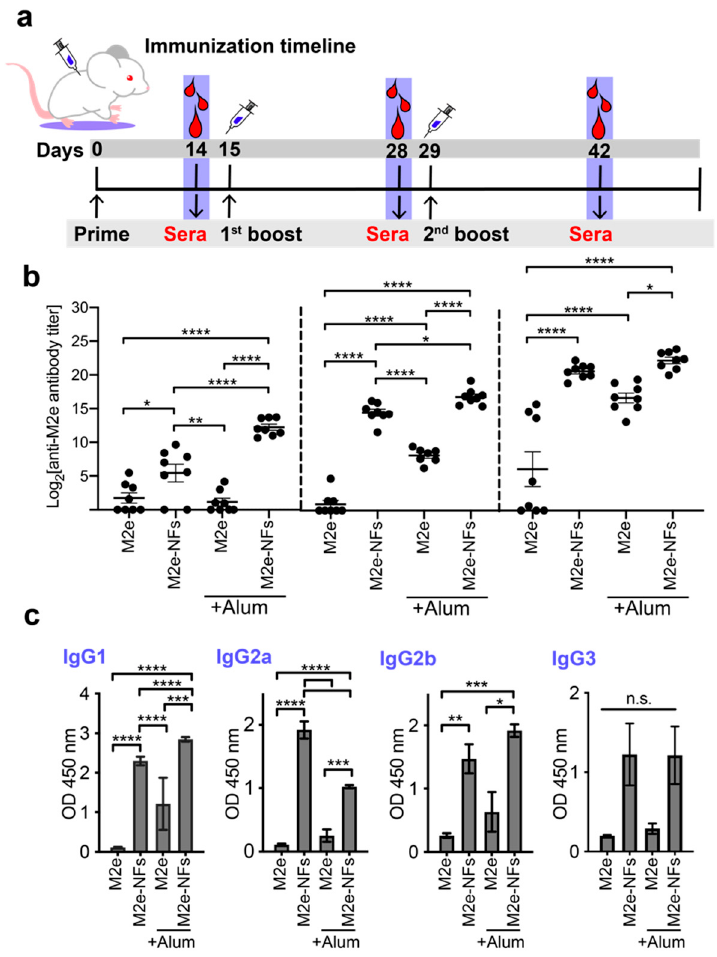
Figure 7. Antibody specific immune response in subcutaneously immunized mice. ( a ) Schematic representation of the immunization schedule. ( b ) M2e-specific serum IgG antibody titers of mice immunized with M2e peptide, M2e + Alum, M2e-NFs, and M2e-NFs + Alum, 50 nmol / dose. ( c ) IgG subtypes from sera collected at day 42 PPI. Data are expressed as arithmetic means ± S.E.M. One-way analysis of variance (ANOVA) with multiple comparisons was used and P values of < 0.05 were considered significant with levels of significance indicated on the graphs by asterisks: *, p = 0.01; **, p = 0.001; ***, p = 0.0001; and ****, p < 0.0001.